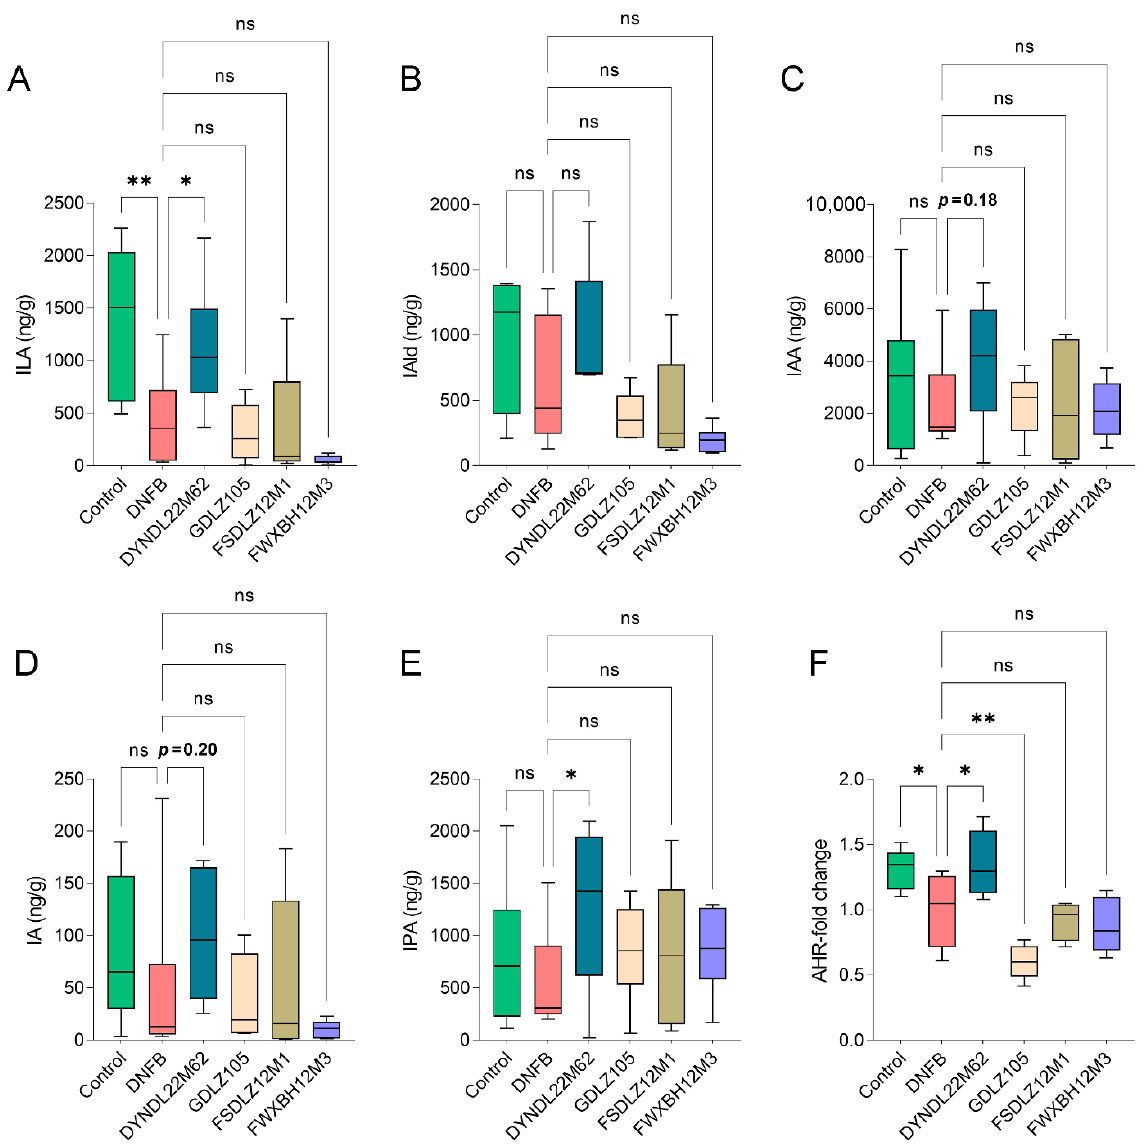
Figure 3. L. reuteri strains affected indole derivatives levels and the expression of AHR. ( A – E ) Changes in ILA, IAld, IAA, IA, and IPA levels in fecal samples. ( F ) Fold-change of AHR expression. * p < 0.05, ** p < 0.01 vs DNFB group, ns, no significance. ILA, indolelactic acid, IAld, indole-3-aldehyde, IAA, indoleacetic acid, IA, indoleacrylic acid, IPA, indole propionic acid.